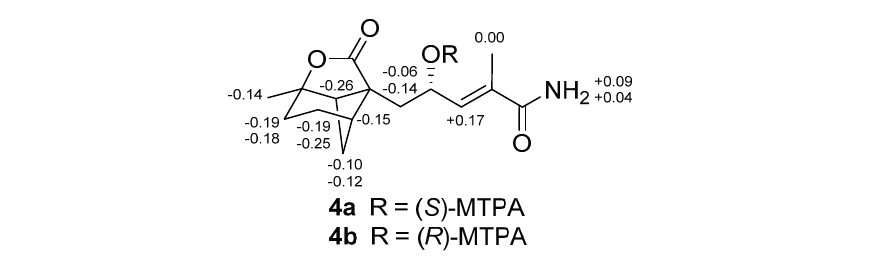
Figure 4. ∆δ Values (in ppm) = δ S − δ R obtained for ( S )- and ( R )-MTPA esters 4b and 4a